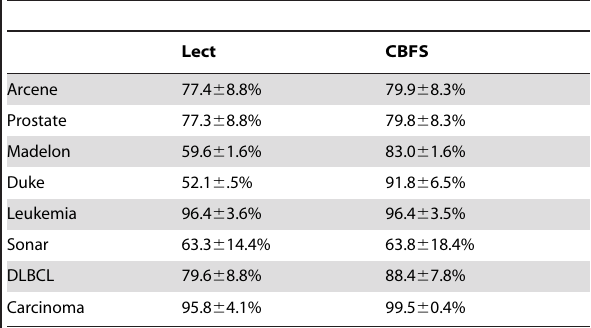
Table 4. Classification accuracies and validation errors for Lect and